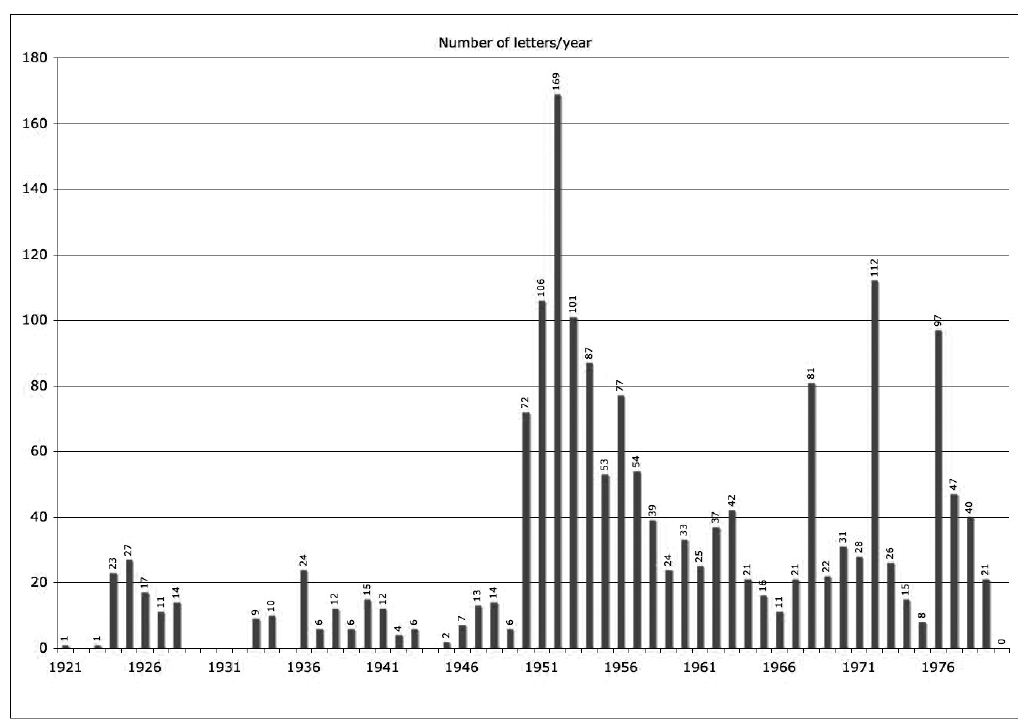
Fig. 2. Graphic summary of the decade-long distribution of the letters received by Bendandi and preserved in the «La Bendandiana» epistolary archive. The distribution of the number of letters per years discloses three pe- riods: 1921-1949, with a modest epistolary activity documented; 1950-1958, with the peak in Bendandi’s epis- tolary activity and an average of 84 letters per year; 1959-1979: the same number of letters as the previous pe- riod but with a decidedly lower average: 36 letters per